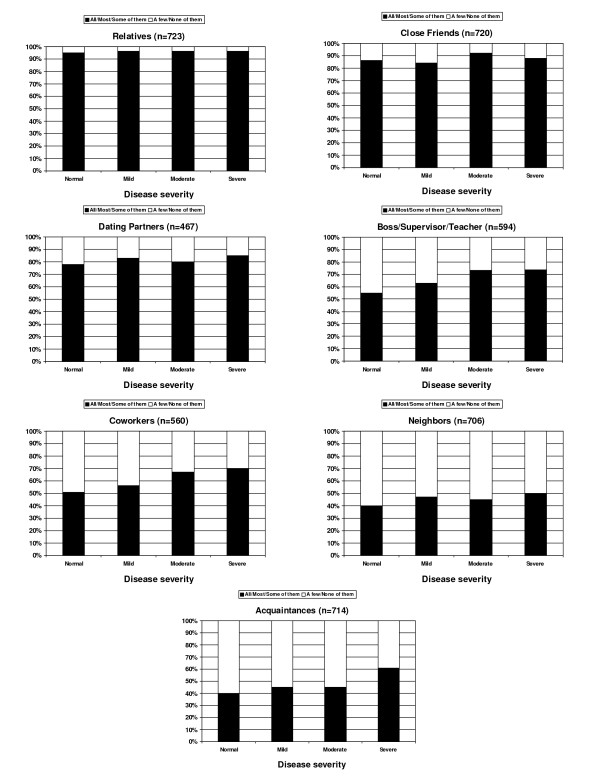
Degree of disclosure by lung function. Pulmonary function categories reflect those defined by the CF Foundation[1]; severe = FEV1 ≤40% predicted; moderate = FEV1 41-70% predicted; mild = FEV1 71-90% predicted; normal = FEV1 > 90% predicted; FEV1 = forced expiratory volume in 1 second